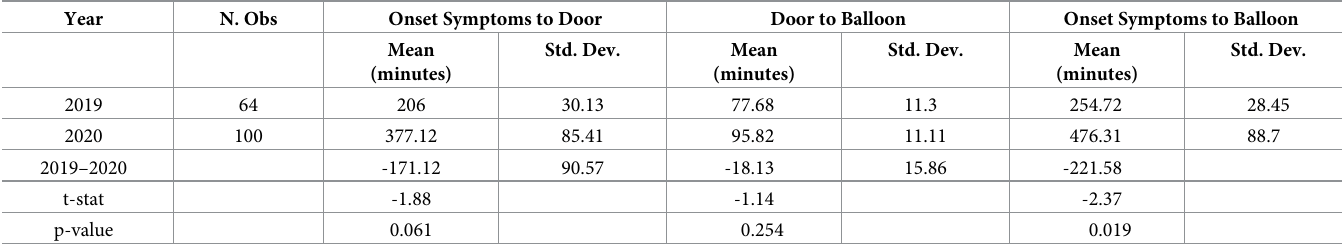
Table 3. Descriptive statistics of AMI time from onset symptoms, by year and